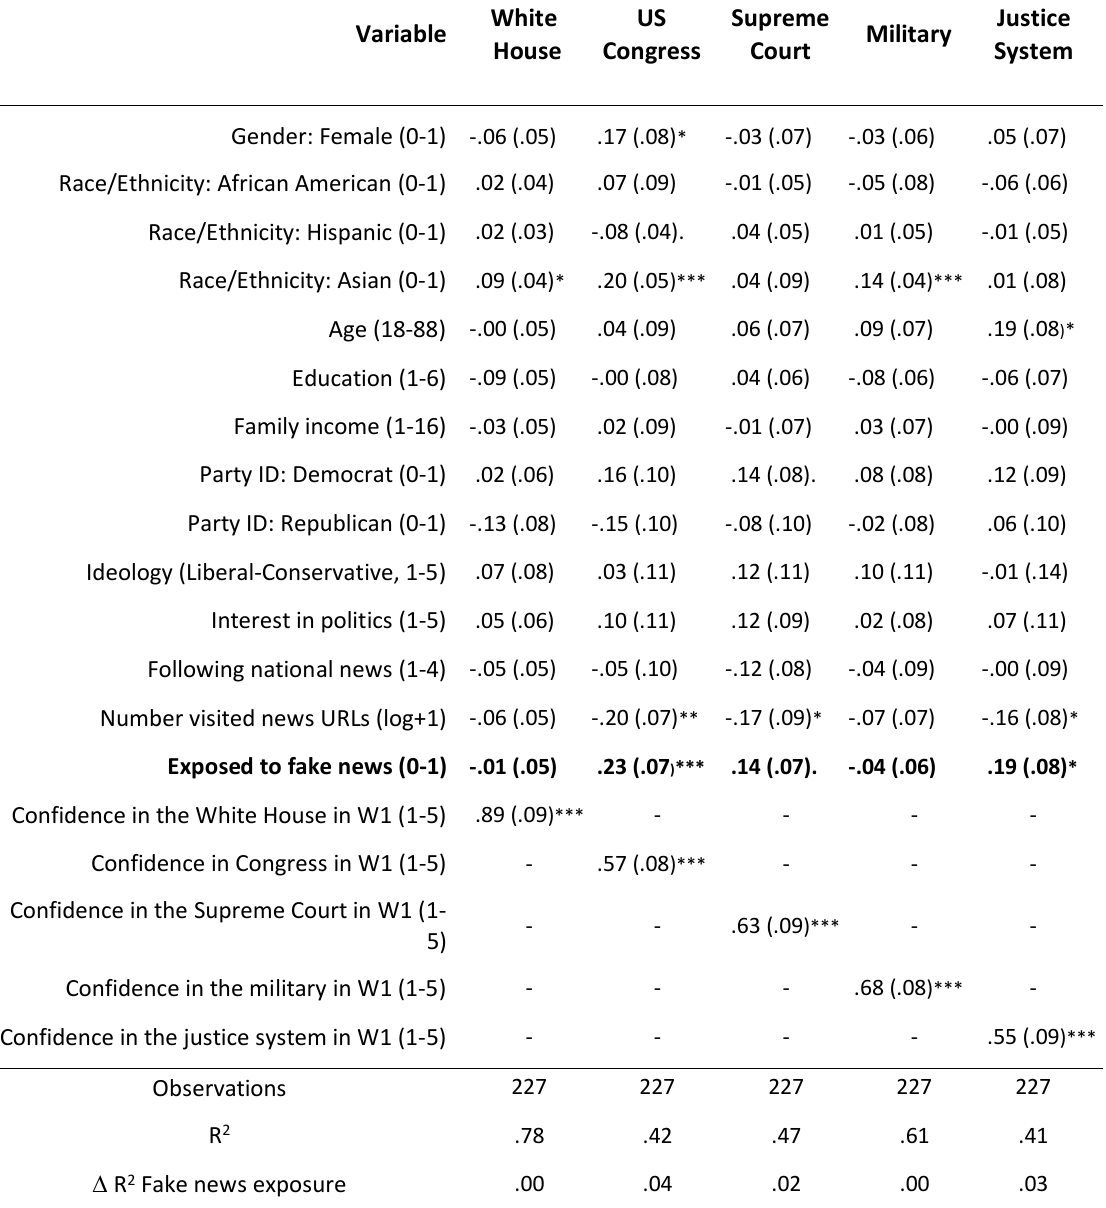
Table B1. Predictors of confidence in political institutions. The table includes standardized coefficients from ordinary least squares regressions with multiple imputation